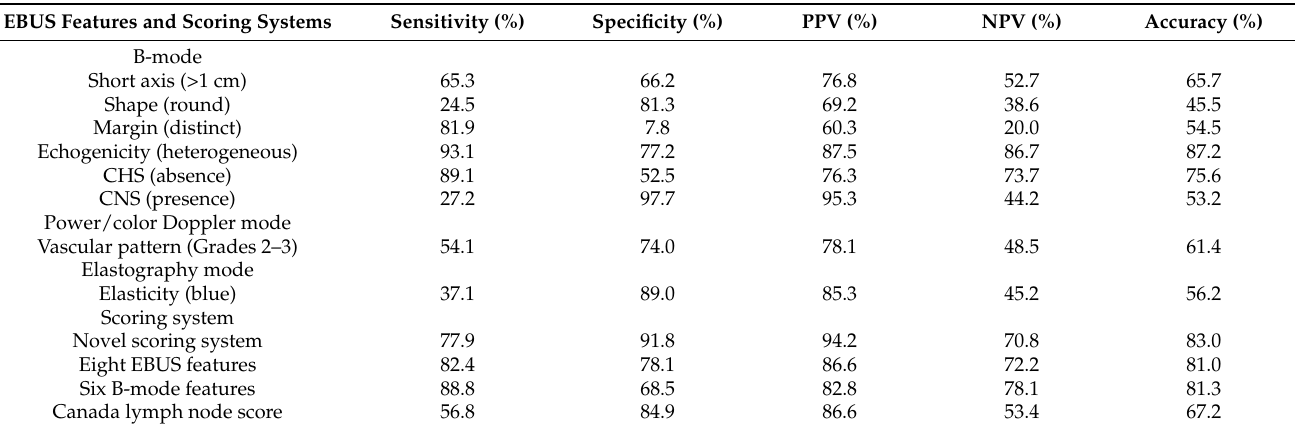
Table 4. Diagnostic test parameters of each EBUS feature and predictive scoring system for malignant lymph nodes.